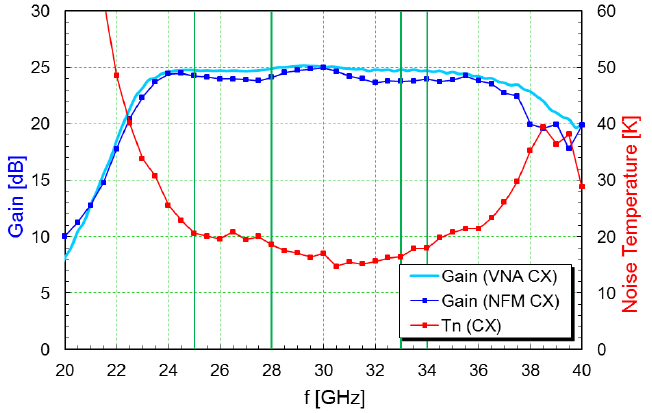
Figure 12. Gain and noise temperature plots of the Ka-band LNA at 14 Kelvin ambient temperature.